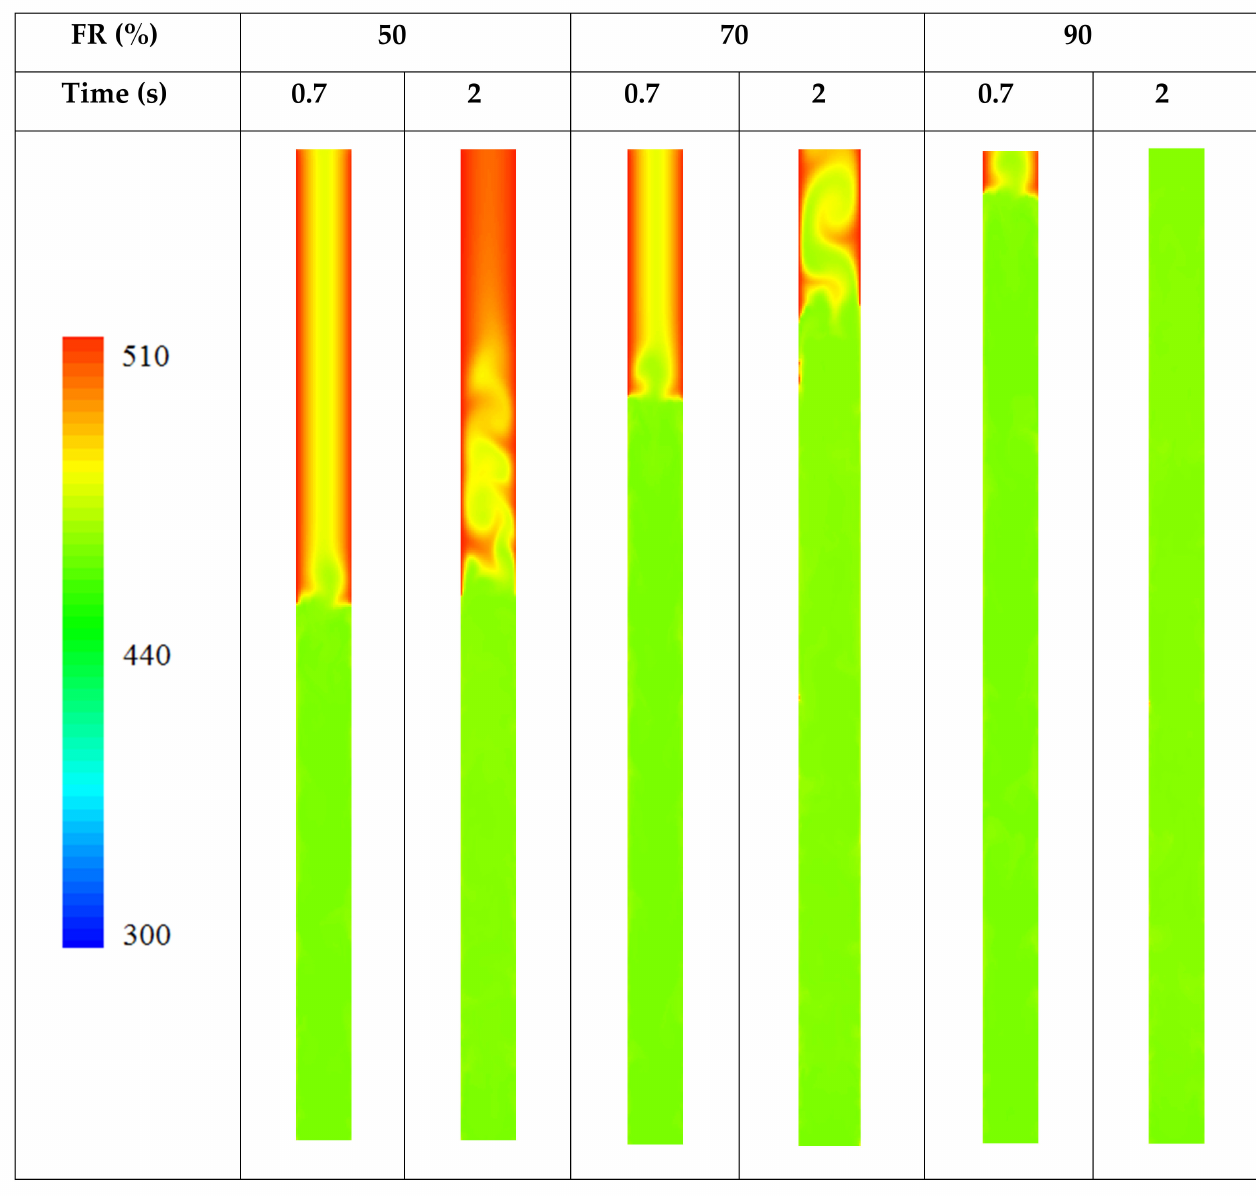
Figure 9. Comparison of temperature contours for different filling ratios at two different